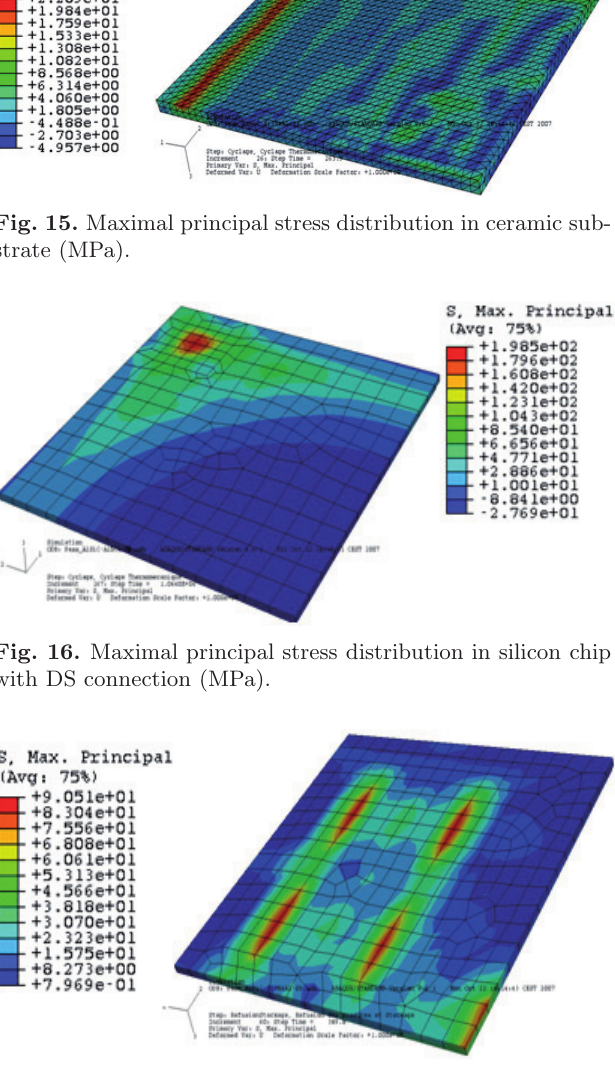
Fig. 17. Maximal principal stress distribution in silicon chip with PB connection (MPa).